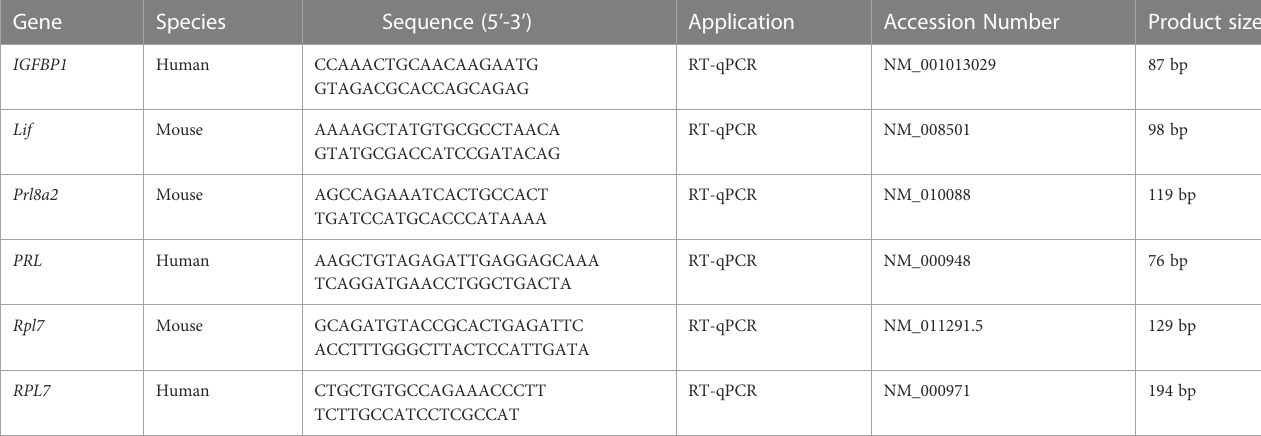
TABLE 1 Primer sequences used in this